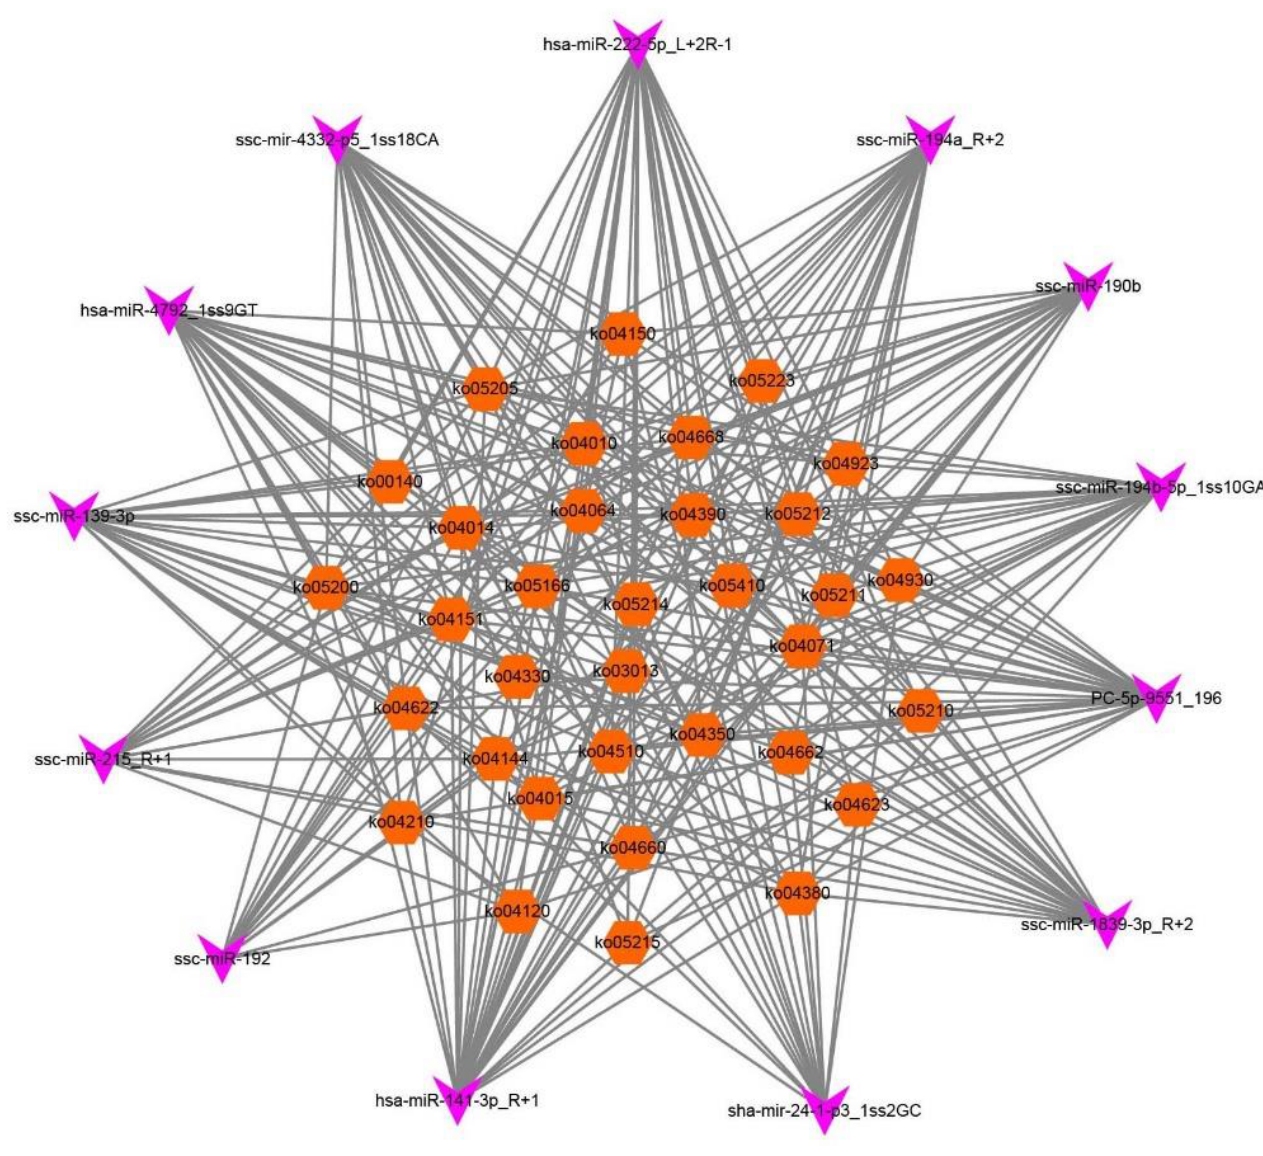
Figure 4. DEmiRNA – KEGG network analysis. The miRNA – KEGG network was built based on the interactions between signal pathways and their respective DEmiRNAs. For the network, the diamond nodes represent miRNA, and the orange nodes represent pathways affected by two/three DE miRNAs.